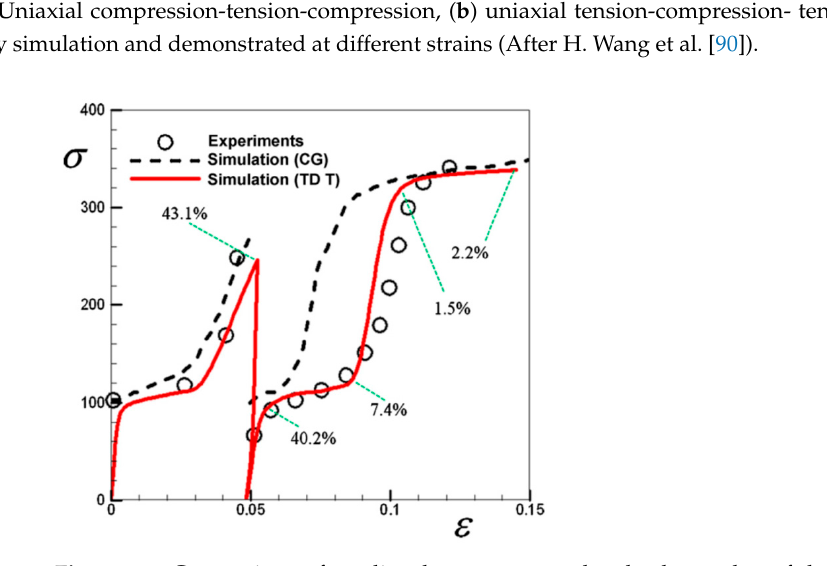
Figure 11. Comparison of predicted stress versus the absolute value of the accumulated strain in AZ31B Mg alloy versus the experimental data subjected to in-plane compression followed by compression loading through the thickness along the RD. The twin volume is predicted by simulation and demonstrated at different strains (After H. Wang et al. [90]).